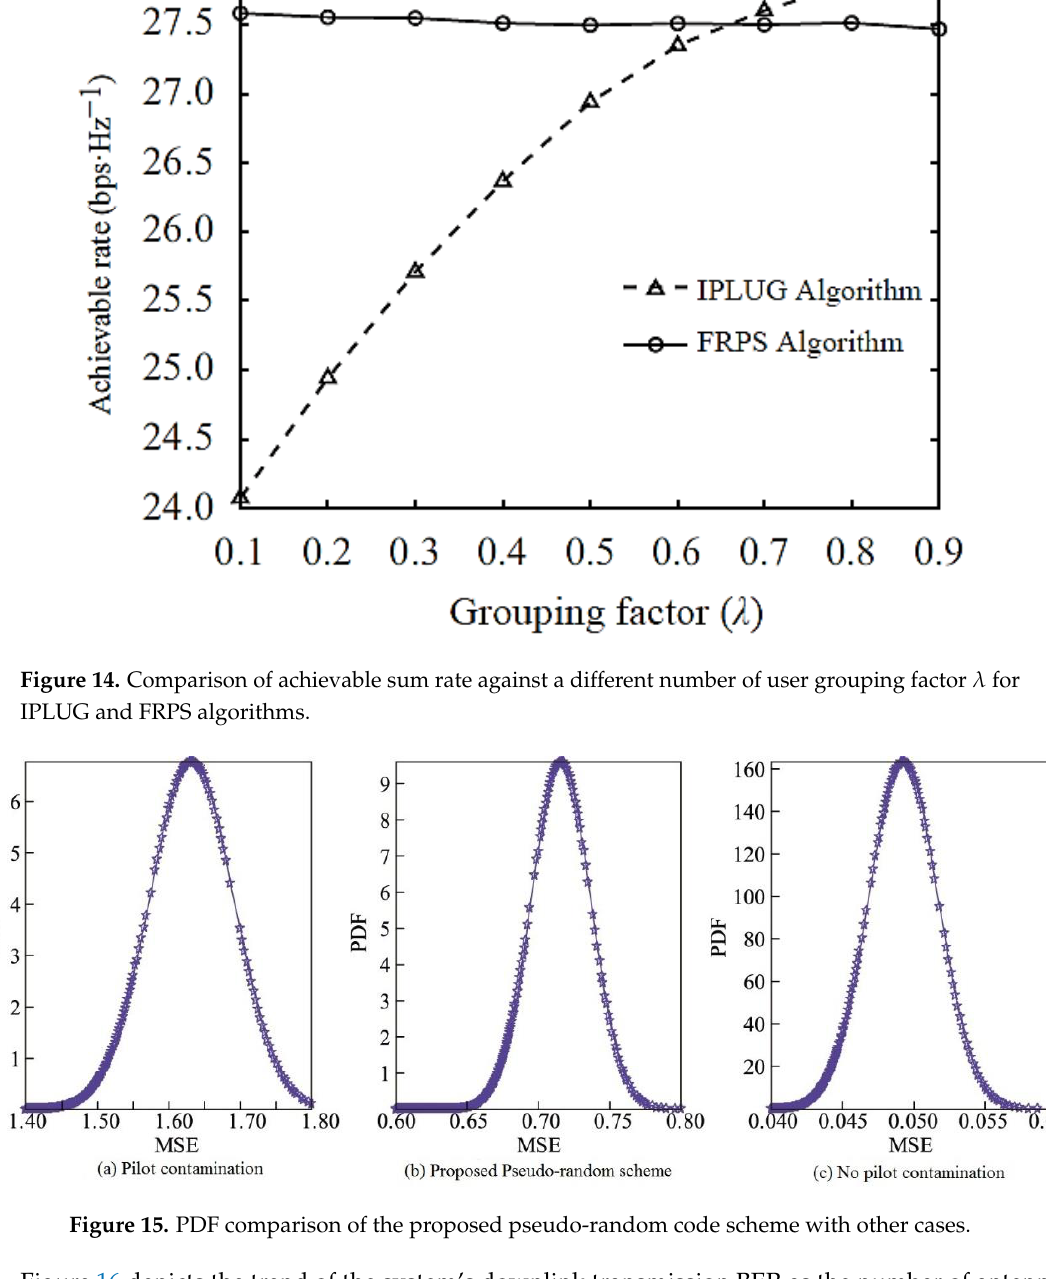
Figure 16. Comparison of the BER of the proposed pseudo-random pilot design scheme with other schemes against the number of BS antennas. When the proposed pilot design scheme or no contamination is used, the performance of the system is significantly improved with the increase of the number of antennas. Figure 17 depicts the trend of the downlink BER of the system as the average transmit power 𝜌 𝑓 of the BS increases. The results are analyzed for different pilot lengths. The number of users per cell 𝐾 = 8 , the number of antennas configured by the BS 𝑀 = 100 . As can be seen from Figure 17 that when the number of BS antennas is large, the increase of the BS transmit power is effective for improving the system performance, but when it exceeds a certain value, the system performance will not be improved, and this value will be affected by the severity of pilot contamination. It can be seen from Figure 17 that in the case of complete pilot contamination, the system performance will not be improved after the BS transmission power reaches 25 dB. In the case of the proposed pilot design scheme (pseudo-random code) or no contamination, this value is greater than 25 dB. At the same time, it can be found that in the case of complete pilot contamination, the system performance will not be improved with the